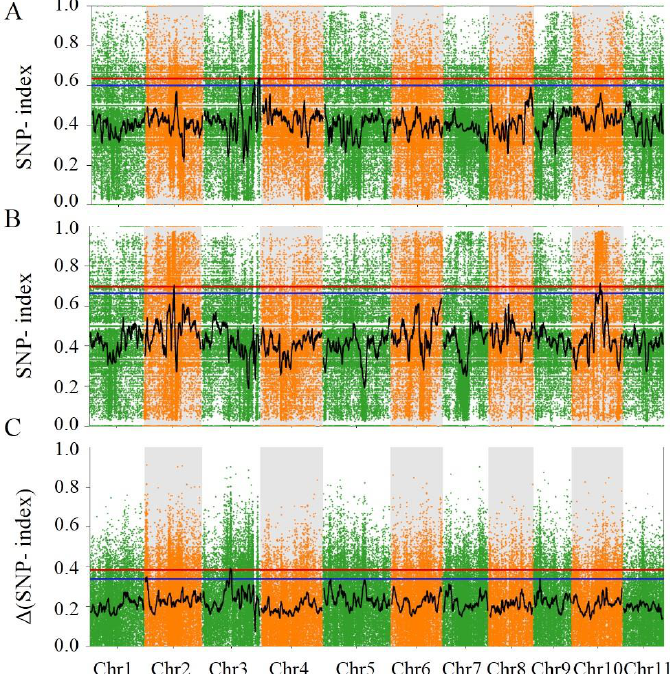
Figure 7. Identification of fruit-flavor-related QTLs in strong- and weak-flavor bulks ( A – C ). Single- nucleotide polymorphism (SNP) index plot of strong-flavor bulk, weak-flavor bulk, and ∆ SNP-index plot from QTL-seq analysis, respectively. The X-axis represents the position of eleven chromo- somes and the Y-axis represents SNP-index values calculated based on 1-Mb intervals with a 10-kb sliding window.